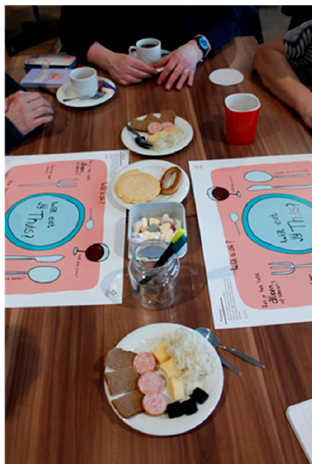
Figure 1. Example of materials used in Samsam.